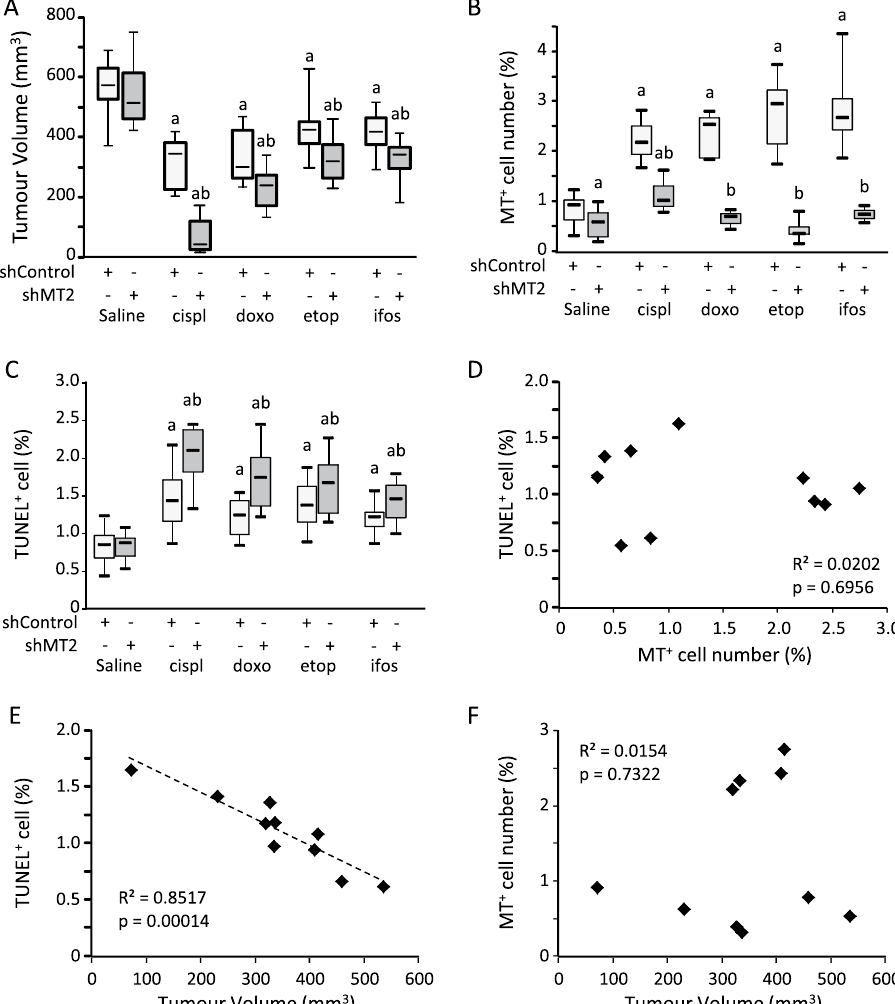
Figure 4. Silencing of MT2 improves chemotherapy cytotoxic effects in a preclinical model. K7M2 cells modified with shControl or shMT2 were injected intramuscularly into the thighs of SCID mice and administered with chemotherapy as described in the Methods section. ( A ) Boxplot specifying the tumour volume at dissection. a indicates a statistically significant difference vs . saline ( p < 0.05); b indicates a statistically significant difference vs . shControl group (p < 0.05). ( B ) Boxplot specifying the MTs staining intensity in non-necrotic area. ( C ) Boxplot specifying the apoptotic cells as demonstrated by TUNEL staining in non- necrotic area. ( D ) Spearman correlation between the number of TUNEL positive cells, and number of MTs positive cells. The determination coefficient R² and the significance of the F test (P-value) are also given. ( E ) Spearman correlation between the number of TUNEL positive cells, and tumour volume. The black line shows the regression line. The determination coefficient R² and the significance of the F test (P-value) are also given. ( F ) Spearman correlation between the number of MTs positive cells, and tumour volume. The determination coefficient R² and the significance of the F test (P-value) are also by chemotherapy regimens in the shMT2 group, as compared to treated mice bearing shControl cells-derived tumours: from + 77% with ifosfamide (p = 0.0188 vs . shControl); 2-fold with etoposide (p = 0.0028); 2.2-fold with doxorubicin (p = 0.042) to 2.5-fold with cisplatinum (p = 0.0043). Overall, the TUNEL positive cell number negatively correlated with MT positive cell number and tumour volume (R² > 0.5; p < 0.05; Fig. 4D,E). In contrast, no correlation was detected between MT2 level and tumour volume (R² < 0.1, p > 0.7; Fig. 4F). cells: from − 60% with ifosfamide (p = 0.037 vs . saline; Fig. 6B); − 61% with doxorubicin (p = 0.036); − 76% with etoposide (p = 0.0042) to − 87% with cisplatinum (p = 0.0031). No difference could be detected in the average metastatic surface at sacrifice between shMT2 and shControl groups without treatment (saline; p > 0.3). The average metastatic surface was not more drastically reduced in the mice injected with shMT2 cells, as compared to mice injected with shControl cells when treated with chemotherapy (p > 0.2).